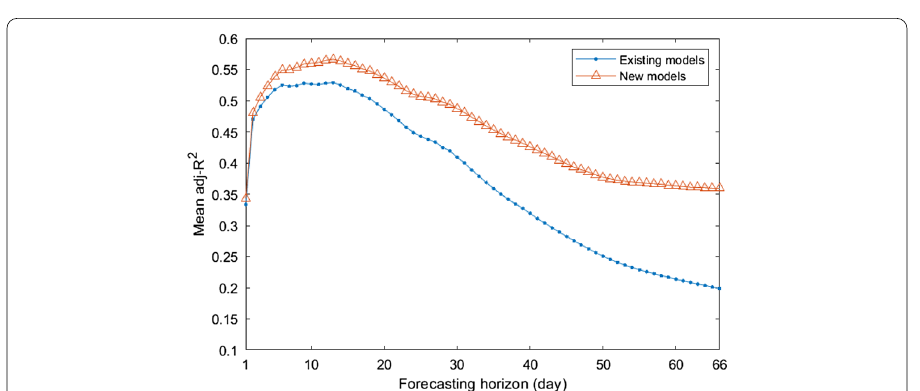
Fig. 4 The mean adjusted R 2 of 11 existing models and 11 new models. Existing models are model (1) to (11) and new models denote model (12) to (22). While calculating the average, the weight of each model is the